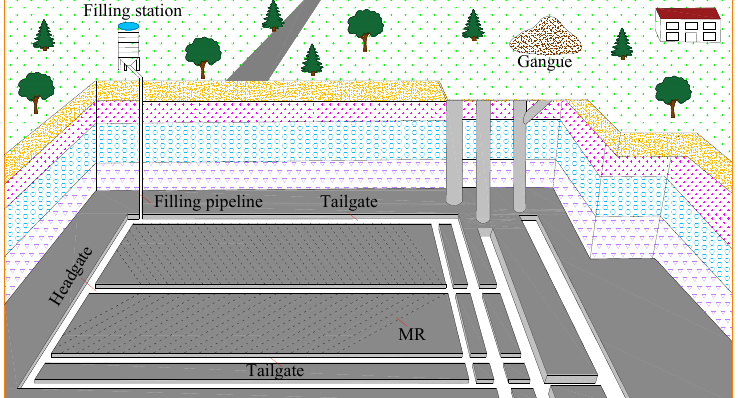
Figure 1. Three-dimensional schematic diagram of using CECB mining method to sequestrate CO 2 .